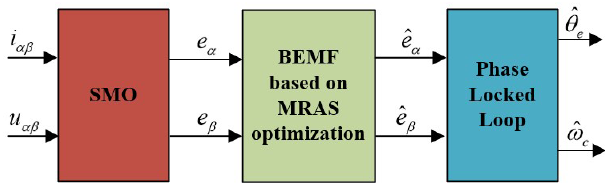
Figure 3. The system block diagram of MRAS–SMO.